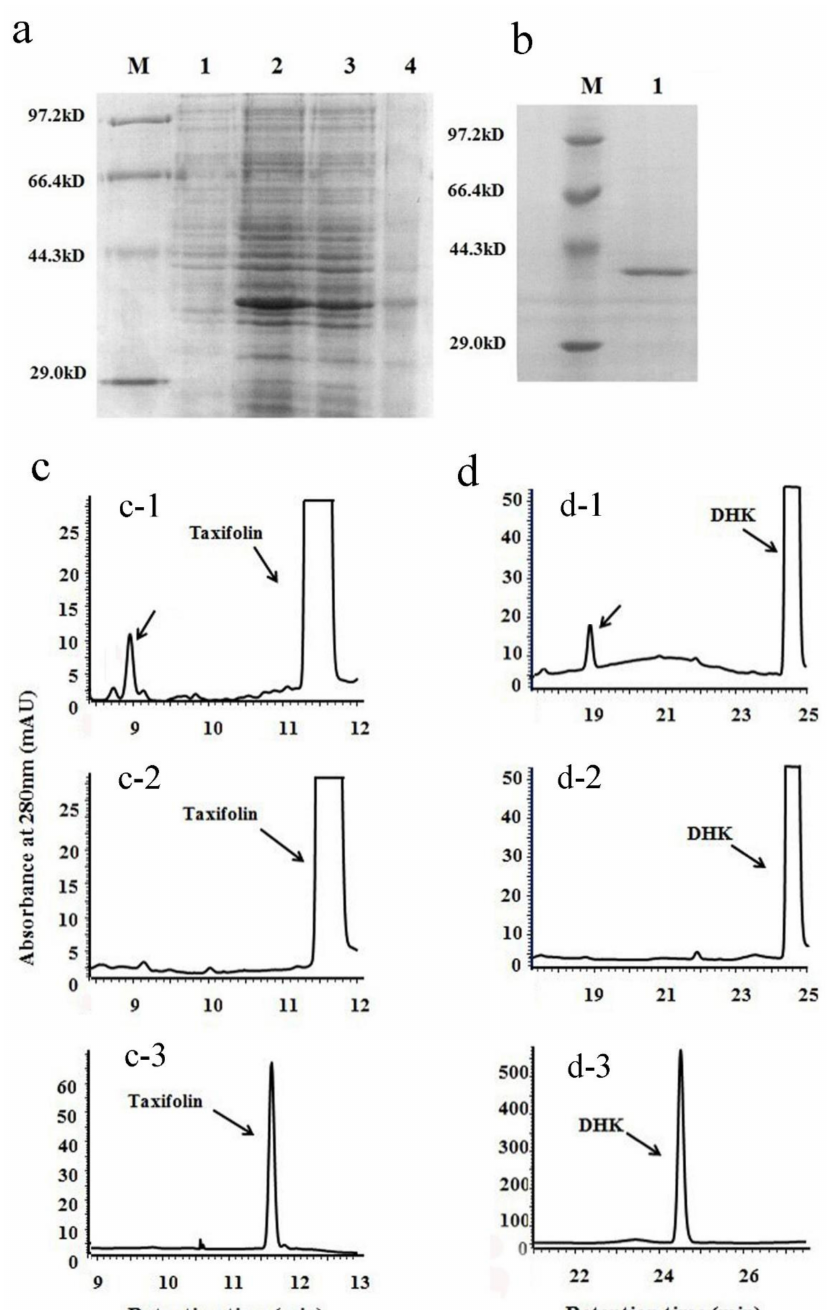
Figure 3. Recombinant protein expression and enzymatic analysis of VbDFR. ( a ) a SDS-PAGE image shows recombinant VbDFR protein induced in E. coli BL21 (DE3) plysS strain. Lane 1: 20 µ g crude protein extracts from BL21 (DE3) plysS/pET28a (+) vector control; lane 2: 20 µ g crude protein extracts from BL21 (DE3) plysS/pET28a (+)-VbDFR. Lane 3: insoluble crude protein extracts from BL21 (DE3) plysS/pET28a (+)-VbDFR. Lane 4: soluble crude protein extracts from BL21 (DE3) plysS/pET28a (+)-VbDFR. M: protein molecular weight marker; ( b ) an image shows recombinant VbDFR purified; ( c ) HPLC profiles show one product formed from the incubation of taxifolin and recombinant VbDFR (c-1) but not denatured VbDFR (c-2); c-3, taxifolin standard; ( d ) HPLC profiles show one product formed from the incubation of dihydrokaempferol (DHK) and recombinant VbDFR (d-1) but not denatured recombinant VbDFR (d-2); d-3 DHK